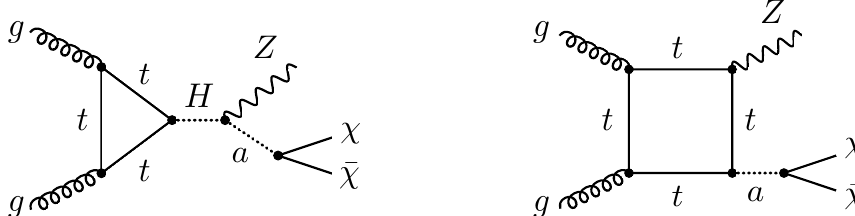
Figure 9 . Representative Feynman diagrams that lead to a Z + E T; miss signal in the pseudoscalar extensions of the THDM. In the case of triangle diagram (left) only the shown graph contributes, while in the case of the box diagram (right) instead of an a also an A exchange is